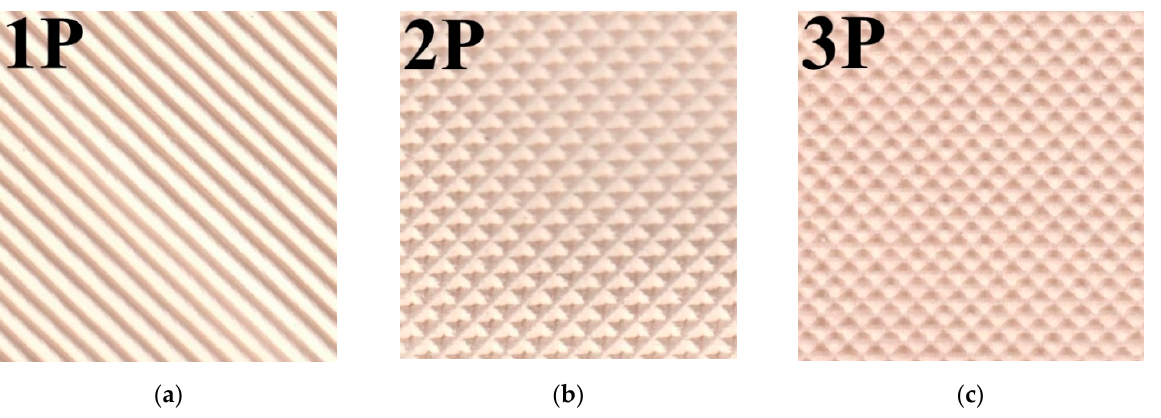
Figure 1. Images of profiled surfaces of IOMs, where ( a ) is profile No 1, ( b ) is profile No 2, and ( c ) is profile No 3.